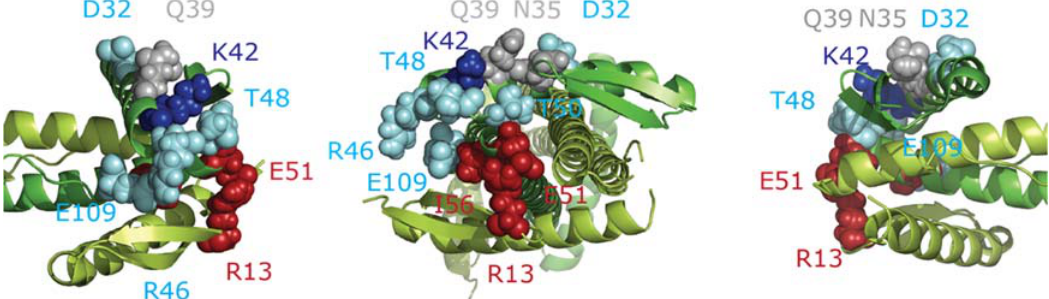
Figure 6. Weakly and non-complementing mutants in ZapA. The E. coli ZapA tetramer [18] is shown with two molecules in limon and two in green. The weakly complementing mutant amino acid residues (D32, T48, R46, E109) made in the present study are shown in cyan, the non-complementing residues (R13, E51, I56) are in red, and the complementing residues (N35 and Q39) in grey. Residue K42, which was cross-linked to FtsZ and which mutated versions were weakly complementing, is shown in blue. Table 2. Morphology of TB28 Δ zapA cells grown in Trypton Yeast (TY) at 37 °C with ZapA mutants expressed form plasmid and induced with 50 µM IPTG for six mass doublings. ZapA Mutants